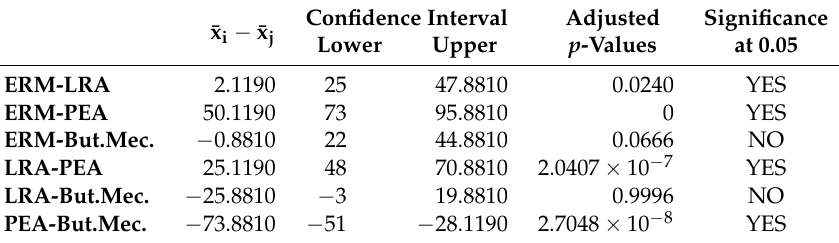
Table 2. Dunn & Sidak Post-Hoc Analysis for